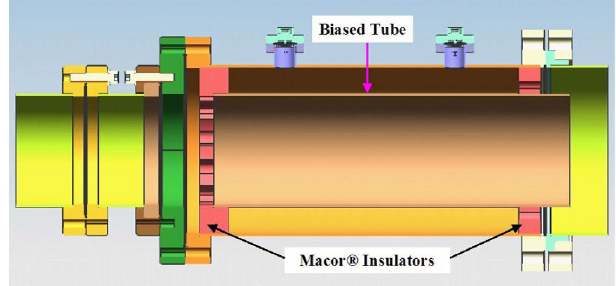
FIG. 14. (Color) Section of electron mirror along the beam axis.